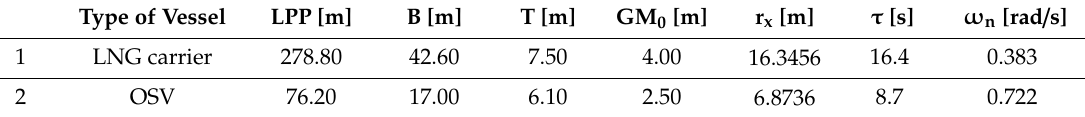
Table 1. Main particulars of ships and parameters of selected loading